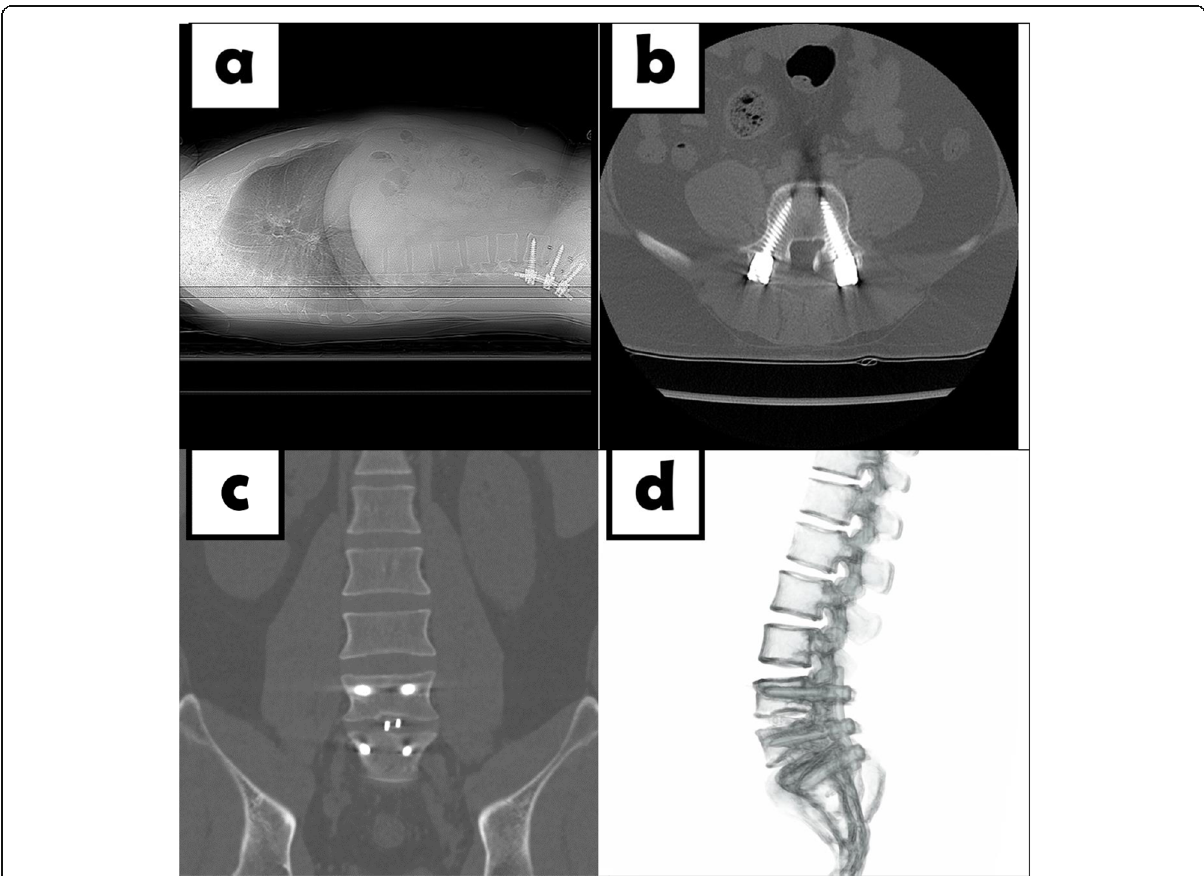
Fig. 5 a Sagittal scout view shows internal fixation of L3, L4, and L5 vertebrae with rods and multiple screws. b Axial cut showing proper position of the screw within the pedicles and in the vertebral bodies. c Coronal reconstruction is showing proper location of the screws within the vertebral bodies and in the pedicles, and disc cages are seen at levels of L4/5 and L5/S1. d 3D sagittal reconstruction image is showing correct placement of screws within the